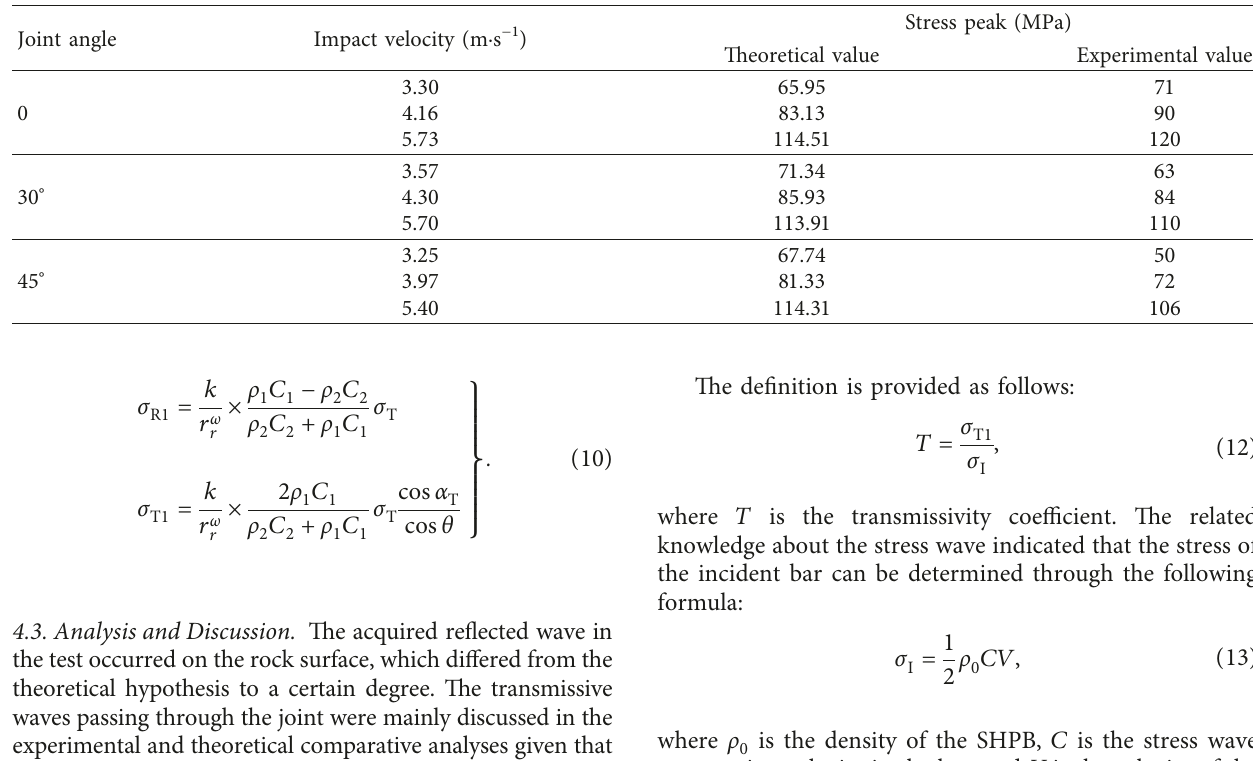
Figure 10: The transfer process of the stress wave in the weak structural plane. Table 4: Stress peak comparison